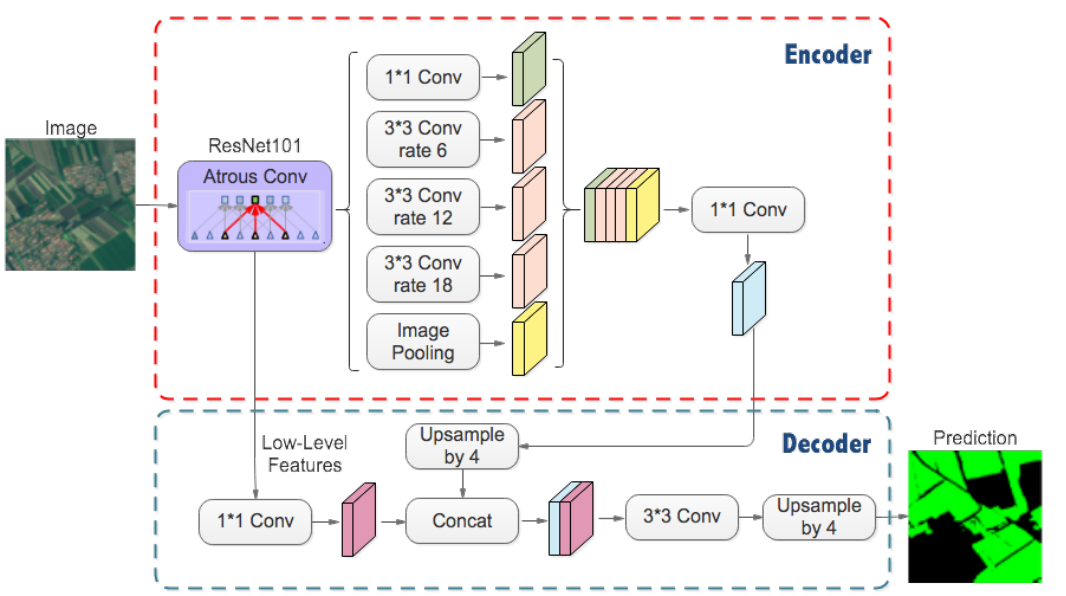
Figure 3. DeepLabv3+ Architecture. (Conv = Convolutional layer).